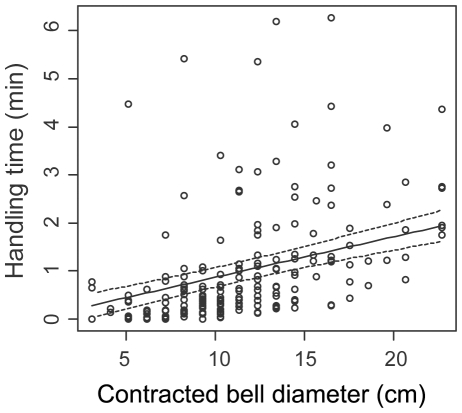
Effect of relative prey size (contracted bell diameter) on handling time of lion's mane jellyfish.Solid line represents mean predicted values with dashed lines indicating ± s.e.m. Circles represent observed values.